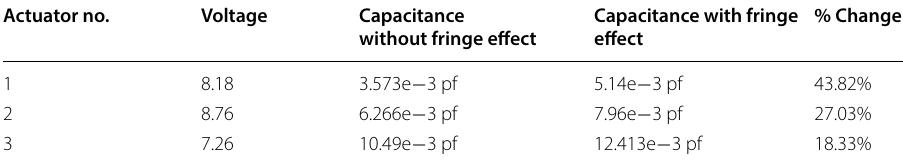
Table 4 Capacitance value simulated by ANSYS for the actuators in Table 1 Actuator no.